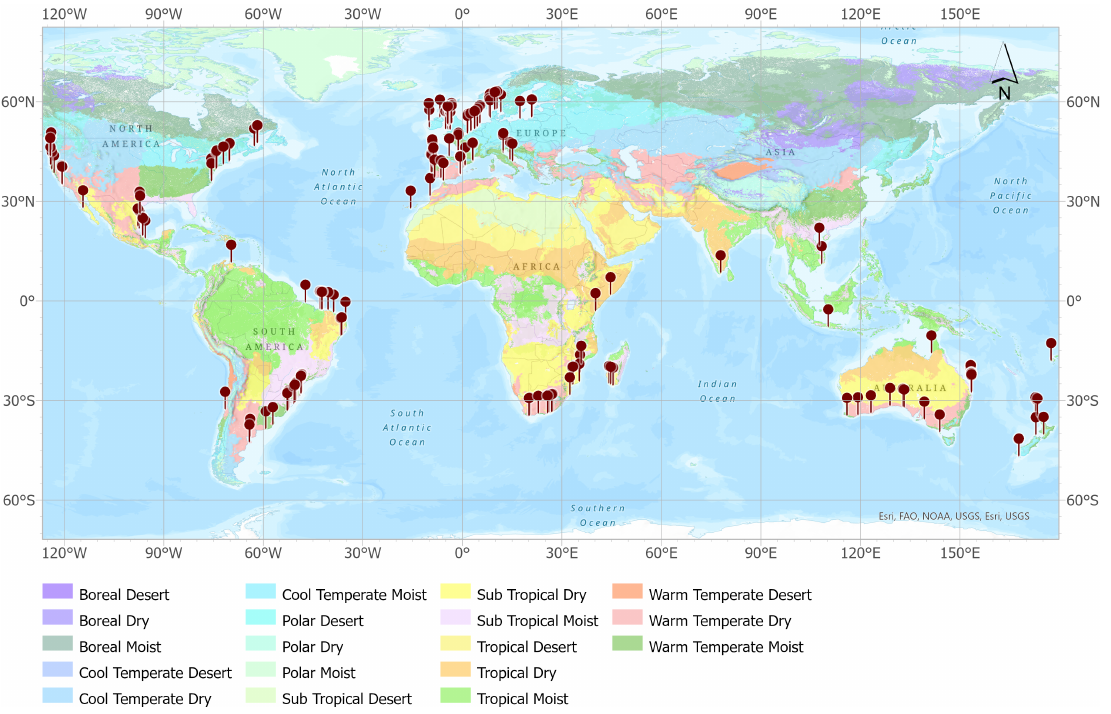
Figure 1. Location of the selected dune sites superimposed on a map of the world climate regions (18 classes [64]). The climate regions are produced as a geospatial integration of the world tem- perature and moisture domains. Source: Esri, USGS, TNC (World Terrestrial Ecosystems Pro Package—Overview). The map was prepared in ArcGIS Pro